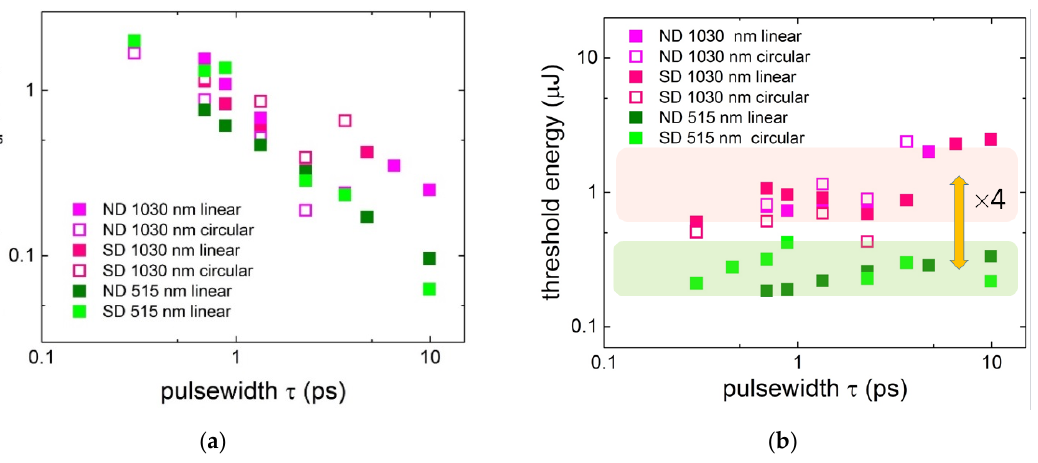
Figure 4. Critical peak pulse power P cr ( a ) and threshold pulse energy E th ( b ) for the onset of filamentation in natural and synthetic diamonds at 515 nm and 1030 nm wavelengths versus laser pulsewidth (adapted from [38]).